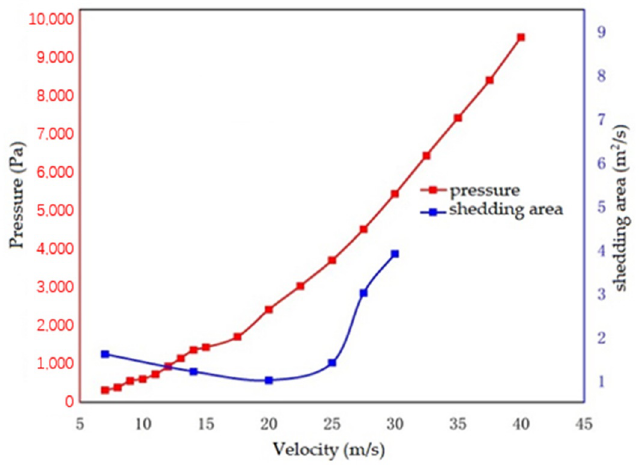
Figure 5. Pressure is compared with the shedding area.